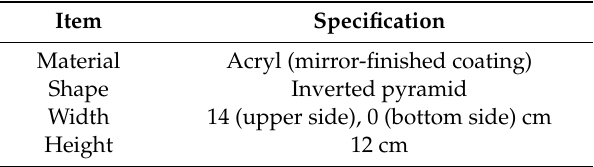
Figure 8. Pyramid reflector and parabolic mirrors. Table 2. Specifications of a pyramid Table 2. Specifications of a pyramid reflector.